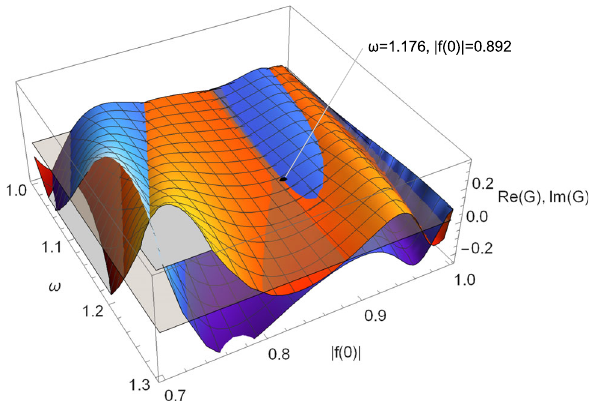
Fig. 1 Three dimensional plot of the solution for elliptic class in four dimensions. The real part of the constraint G (ω, | f ( 0 ) | ) is plot- ted in orange, the imaginary part in blue. The plane of vanishing Re ( G ), Im ( G ) isshowningray,andthisiswheretheintersectionshould be looked for Table 1 Solutions for the elliptic class in five dimensions Solution w | f ( 0 ) | z + α 0 . 999 0 . 673 1 . 246 β 1 . 680